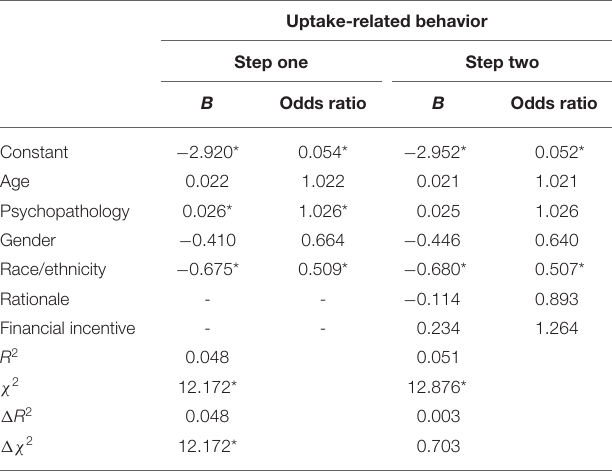
TABLE 5 | Hierarchical logistic regression model predicting uptake-related behavior.